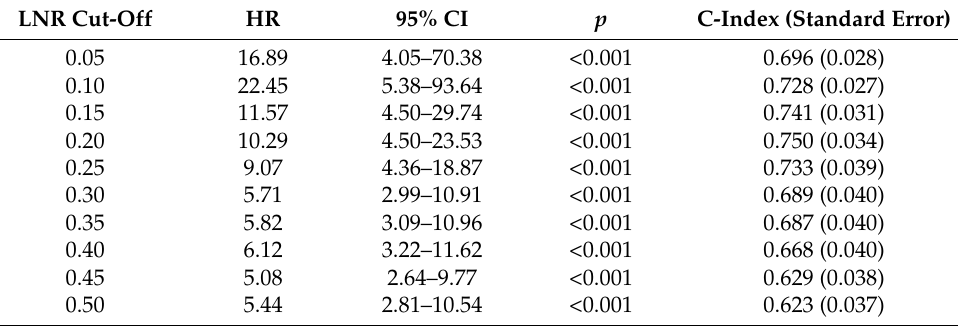
Table 6. Univariate Cox regression analysis for determining the cut-off value of LNR.